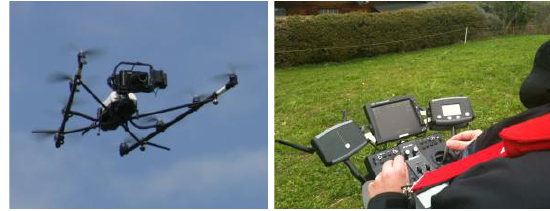
Figure 3. Used UAV system: Octocopter Falcon 8, AscTec The camera can be tilted to any angle along the vertical and horizontal axis. With the provided flight planning software of